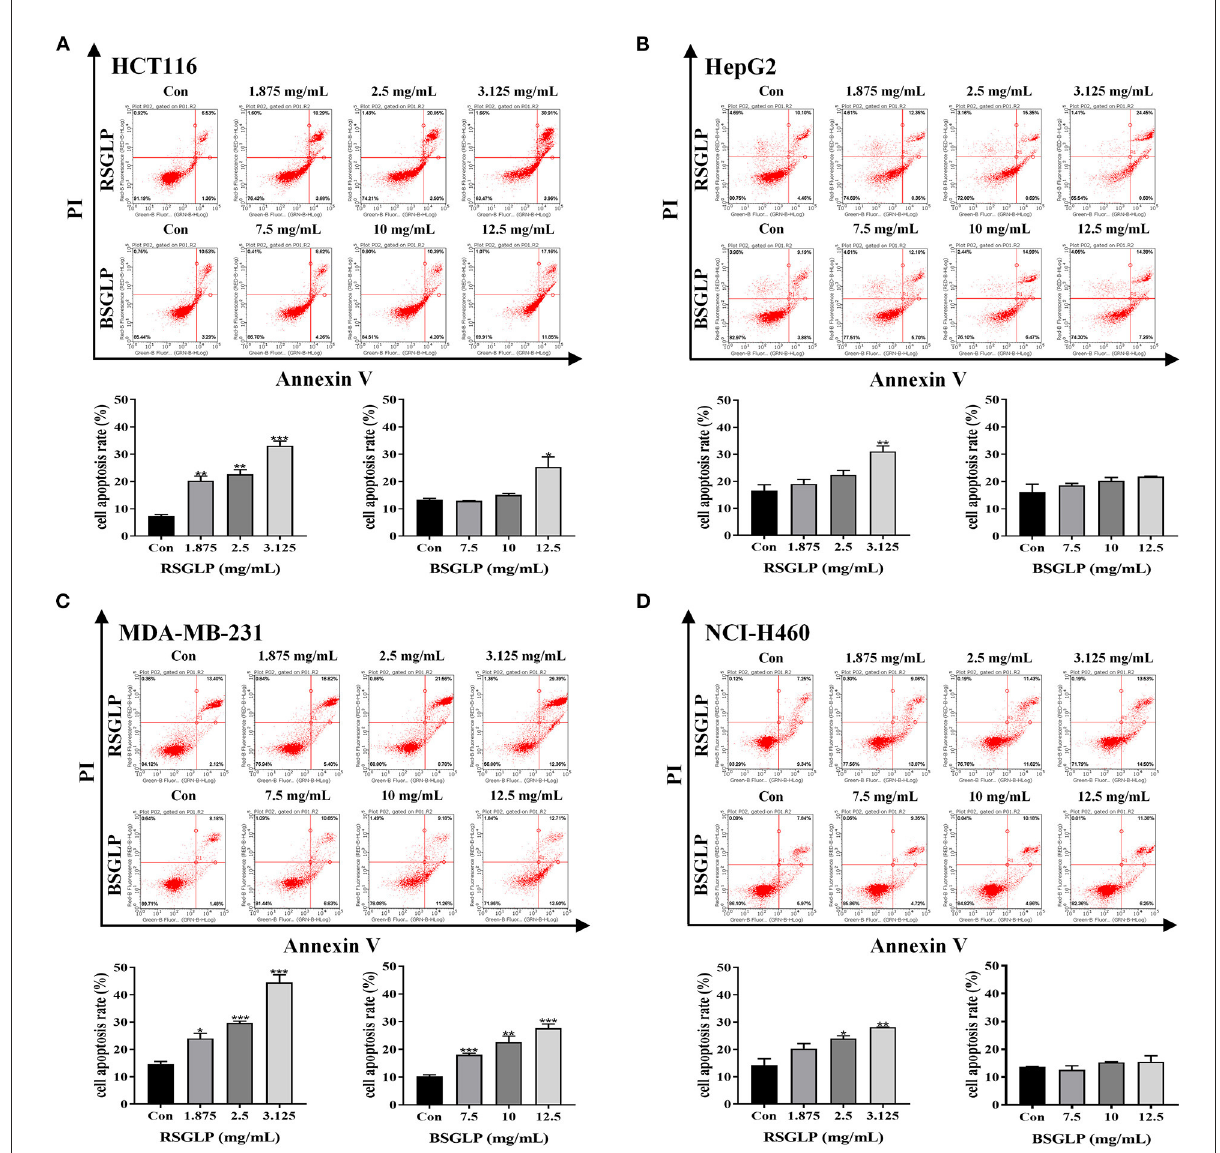
FIGURE3 Comparison of the pro-apoptotic effects of RSGLP and BSGLP in colon, liver, breast, and lung cancer cells as determined using flow cytometry. (A) HCT116. (B) HepG2. (C) MDA-MB-231. (D) NCI-H460. Cells were treated with different concentrations of RSGLP (0, 1.875, 2.5, and 3.125 mg/mL) and BSGLP (0, 7.5, 10, and 12.5 mg/mL) for 48h. The bottom panel is the total percentages of cell apoptosis. Data are presented as mean ± SE from three independent experiments. * p < 0.05, ** p < 0.01, *** p < 0.001, compared with control